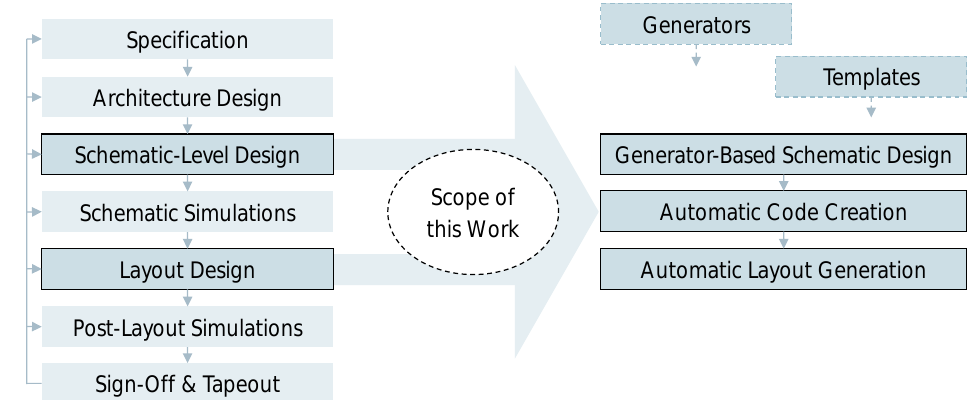
Figure 1. Scope of this Work. From the usual design flow, this work focusses on both schematic and layout design as well as the connection of them in a systematic and reusable way.